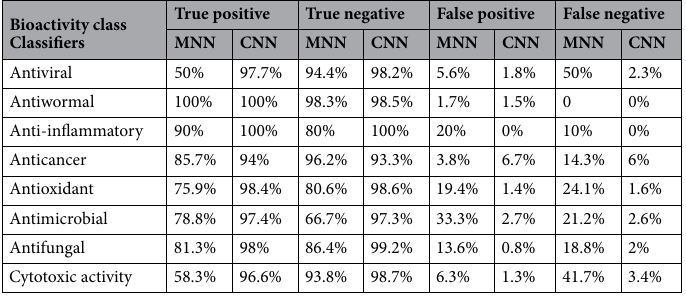
Table 1. The confusion matrix values for MNN and CNN algorithms in testing stage.